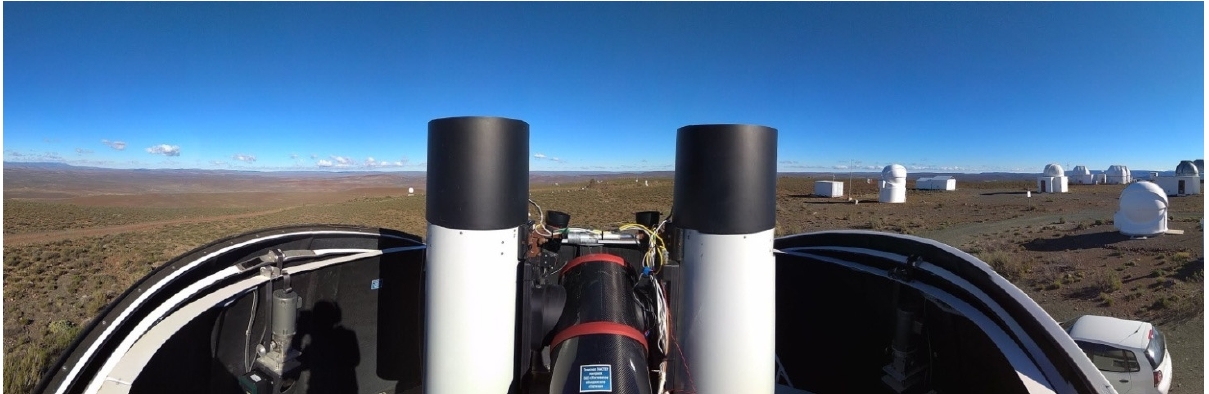
Figure 2. MASTER-SAAO telescope-robot at the South African Astronomical Observatory (SAAO) near Sutherland. Typical design: two 400 mm tubes with a 2 × 4 square degrees field of view and two very wide-field view cameras (VWFC with FOV = 2 × 384 square degrees) at fast mount. The Figure was taken from http://observ.pereplet.ru/ (accessed on 1 March 2021).